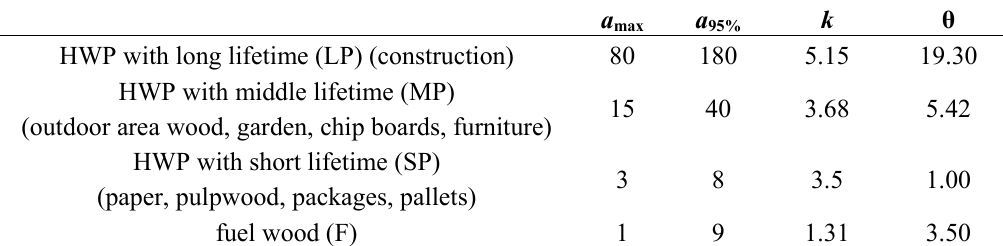
Table 3. The parameters of the Gamma-distributed equation with a as year where 95% of the initial amount is decayed; a maximum decay and a 95% are own estimations based on literature; k and θ are the parameters of the Gamma